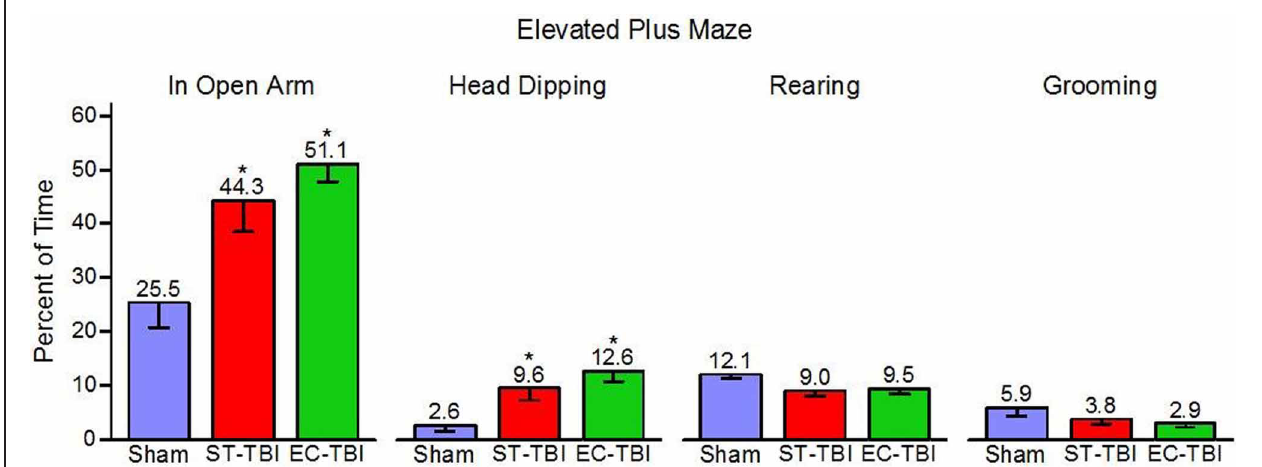
FIGURE 4 | Risk-taking on the elevated plus maze after injury is not remedied by enrichment. ST-TBI and EC-TBI animals spent more time exploring the open arms and head dipping than Sham animals. No